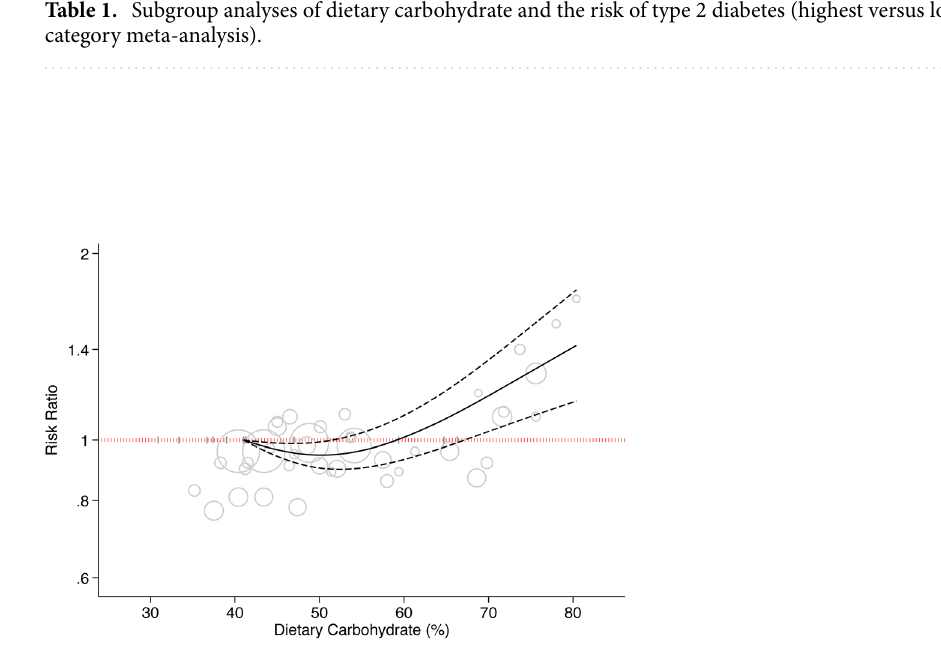
Figure 2. Dose–response association between carbohydrate intake and risk of type 2 diabetes. Solid line represents non-linear dose response and dotted lines represent 95% confidence interval. Circles represent hazard ratio point estimates for carbohydrate intake categories from each study with circle size proportional to inverse of standard error. Small vertical grey lines are baseline carbohydrate intake categories in each